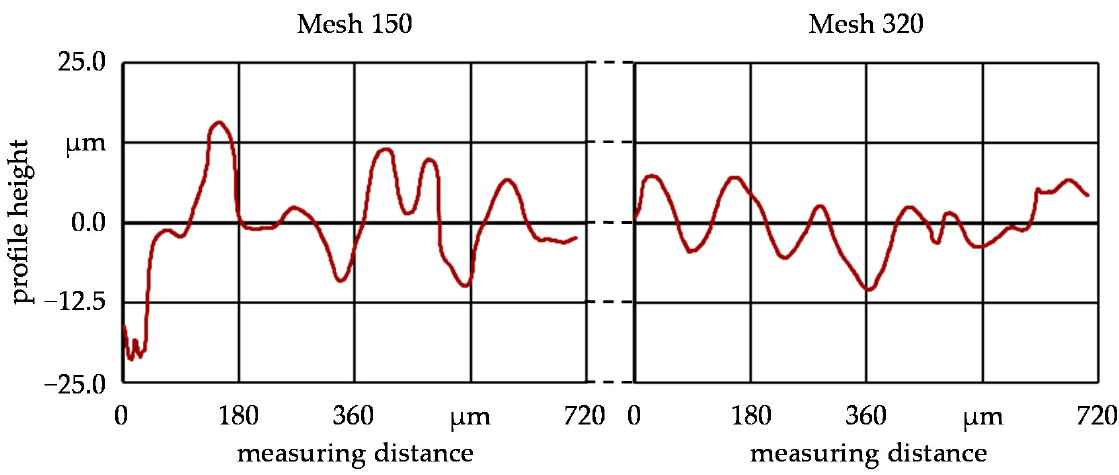
Figure 9. Influence of the grain size of the sharpening block d kSb on the profile height.